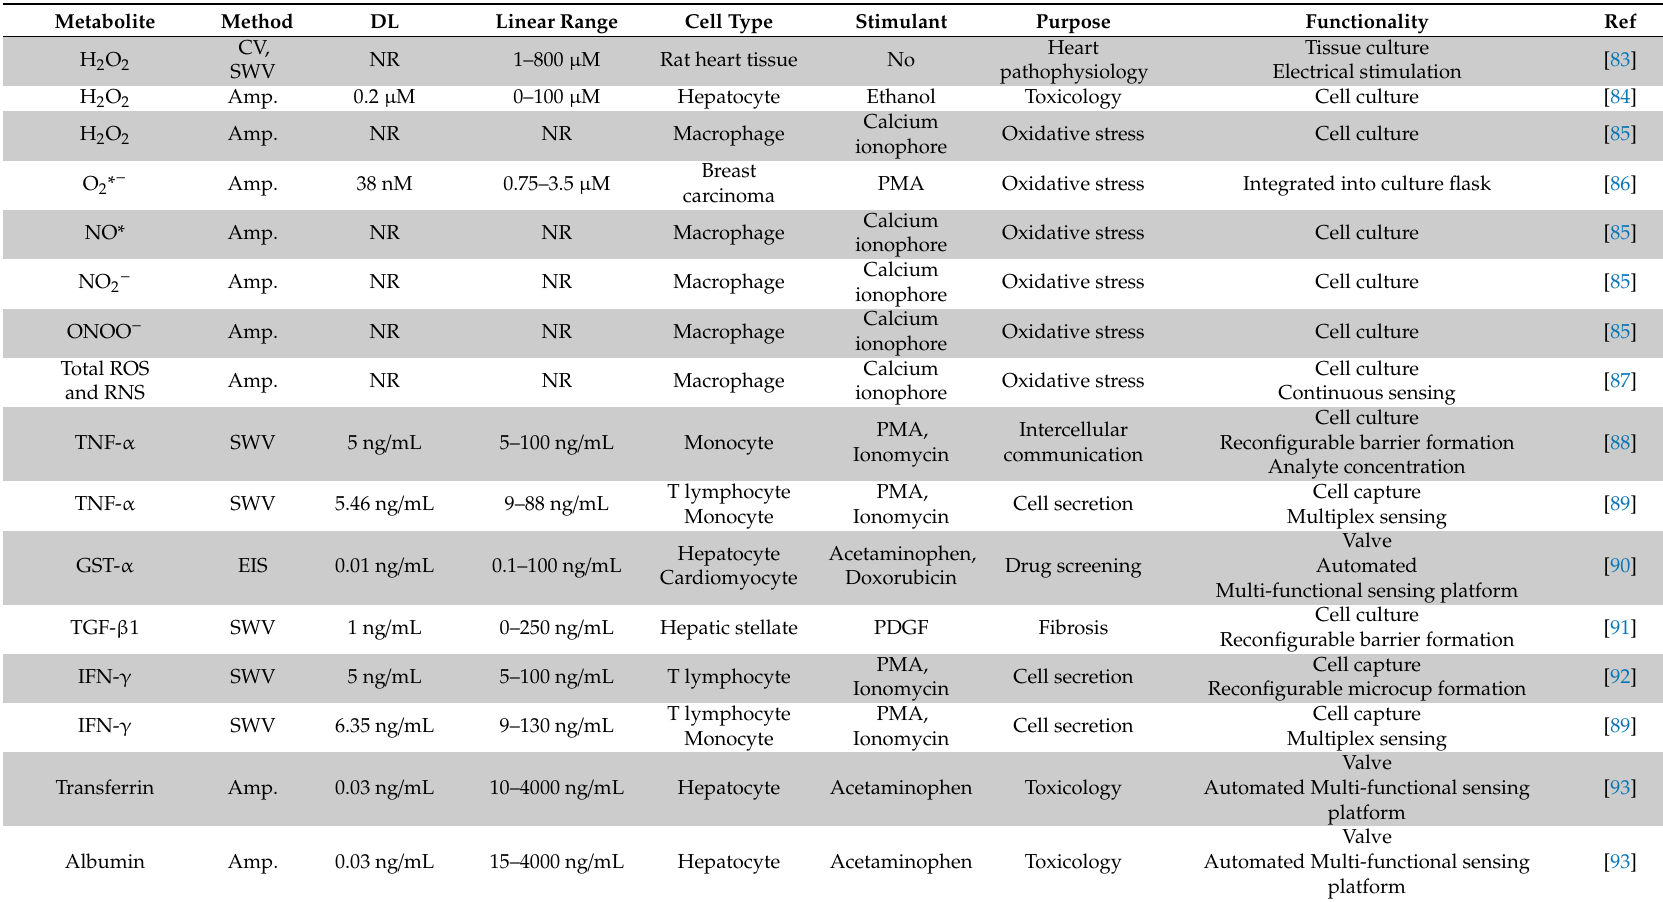
Table 2. LOC systems used for the electrochemical metabolite detection. Lay out like Tab